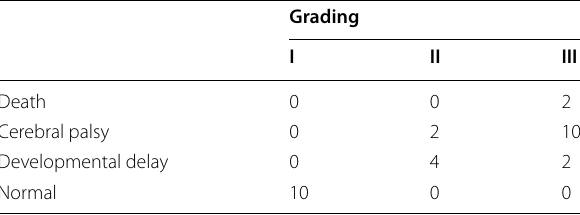
Table 2 Relation between MRS grading and patients’ outcome